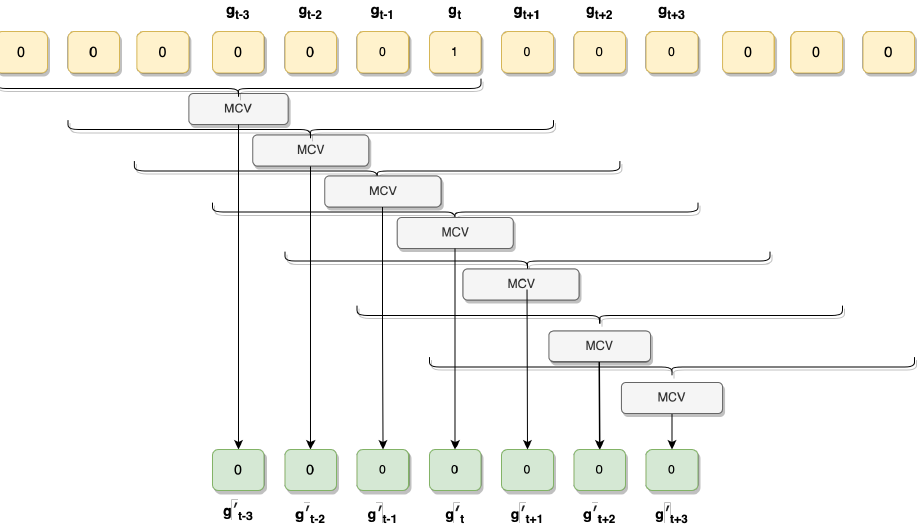
Figure 8. Sliding window majority vote. Here, g t represents the chosen gait after the first pre- processing step and g (cid:48) t represents the chosen gait after the majority vote. MCV is an abbreviation for “Most-Common Value”, and the curly brackets represent the window on which the most-common value is